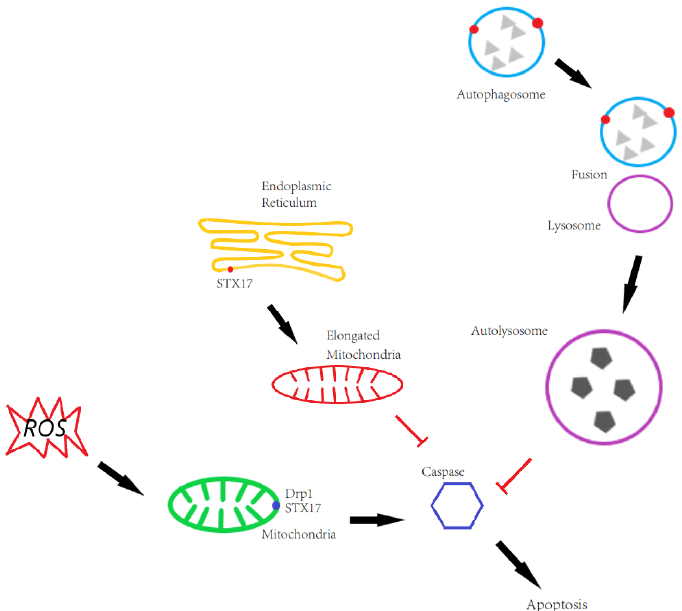
Figure 6. The role of STX17 in regulating apoptosis. On autophagy, STX17 KO blocks autophagosome- lysosome fusion and thus in a way caspase aggregation induces cell apoptosis. On mitochondria, STX17 KO blocks mitochondrial fission and elongated mitochondria provides an additional benefit to escape ROS induced autophagic degradation and thus spares from cell